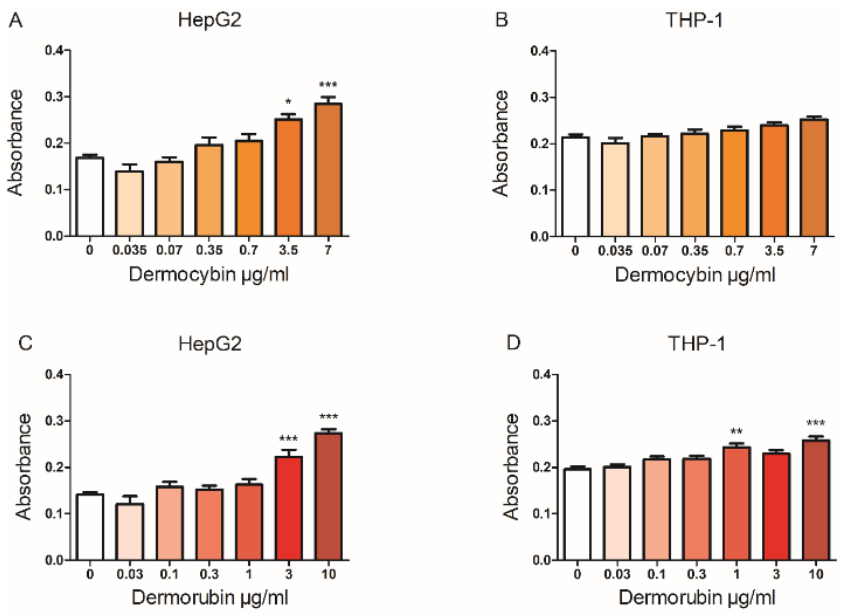
Figure 2. Lactate dehydrogenase test results. ( A ) and ( B ) represent dermocybin, ( C ) and ( D ) represent dermorubin. Data are shown as absorbance mean ± SEM, * p < 0.05, ** p < 0.01, and *** p < 0.001, n = 3.